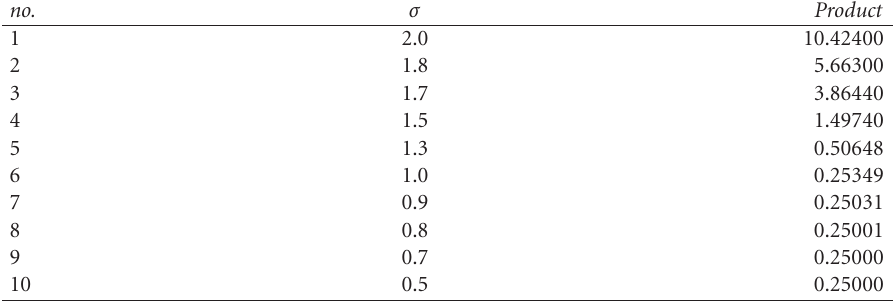
Table 5.2. Convergence of uncertainty product using cosine interpolation function with (cid:2) = 0 . 01 and W = π